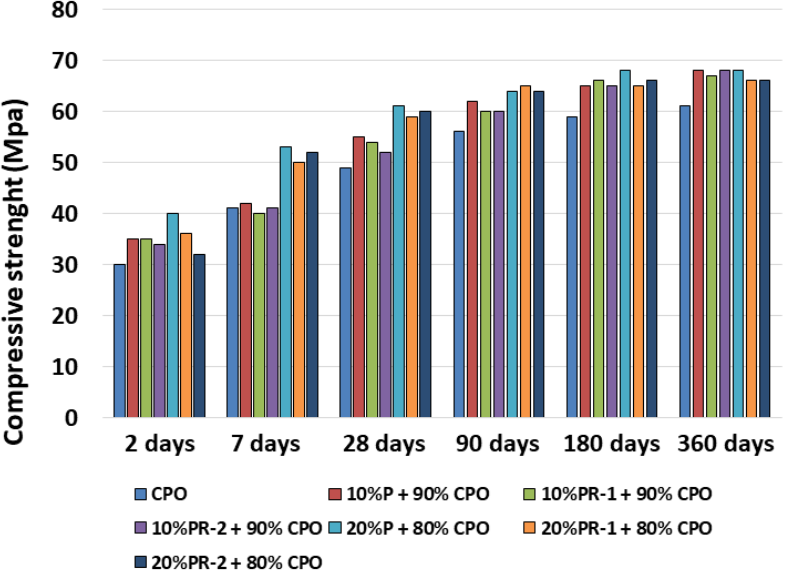
Figure 4. Variation of the compressive strength values for all studied samples. Abd-Elmoaty [50] considers granite powder substitutions of different percentages (5% and 10%). The optimal addition is 10%, generating a positive effect on the tensile strength and without detecting changes in the chemical phases of the mixture with respect to the standard